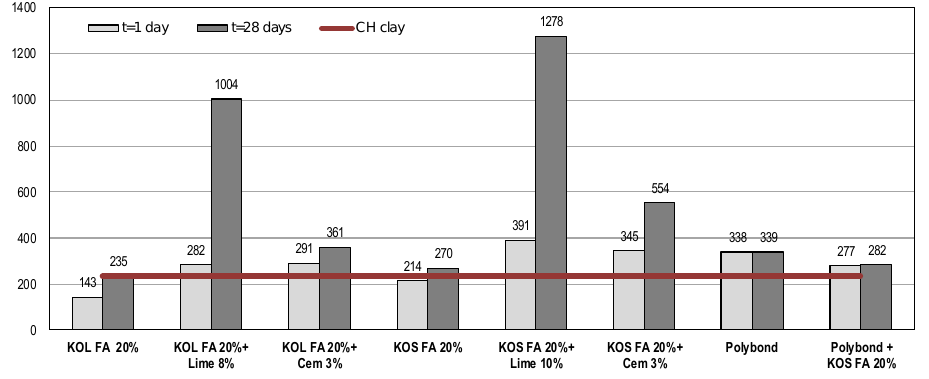
Figure 3. Unconfined compressive strength (UCS) of different mixtures with CH clay.